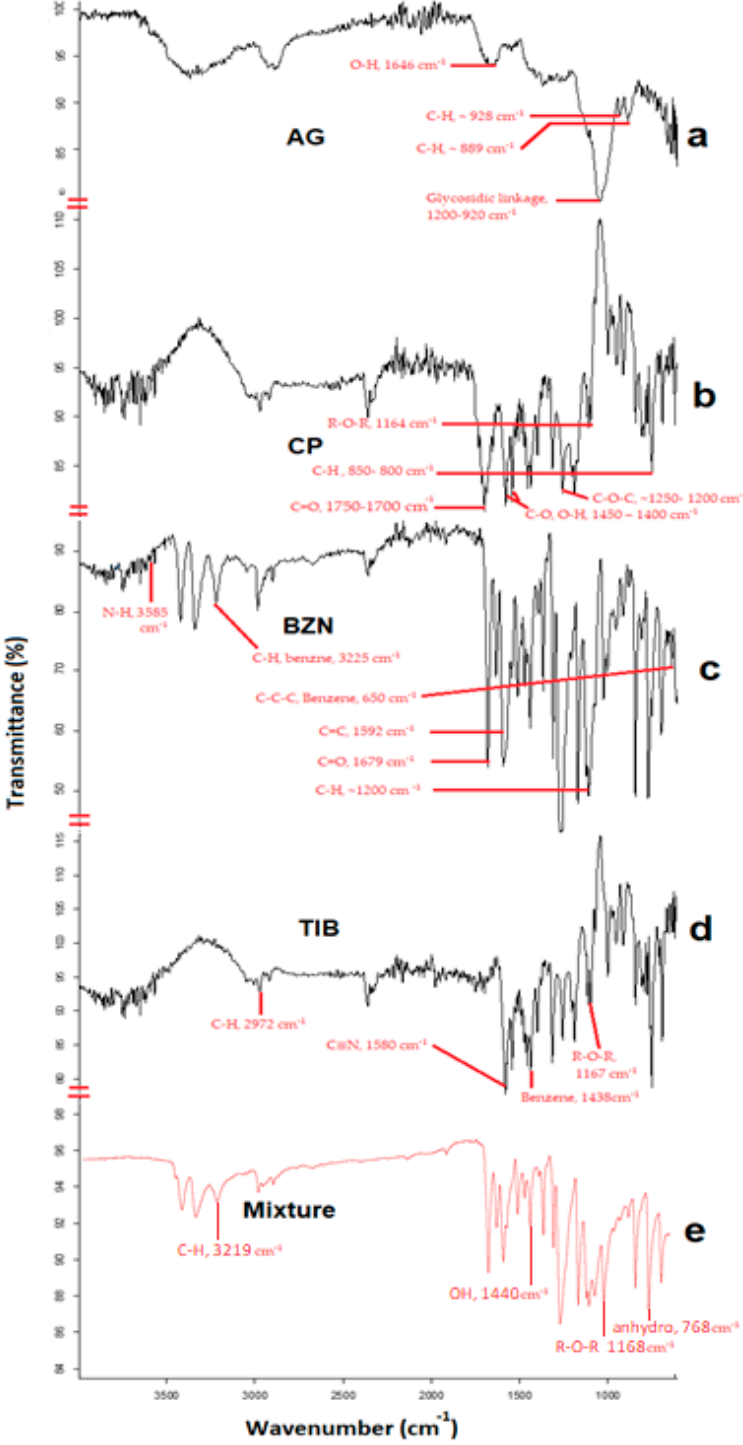
Figure 4. FTIR spectrum of ( a ). AG, ( b ). CP, ( c ). BZN, ( d ). TIB and ( e ). the physical mixture of the drugs and drugs and polymers.